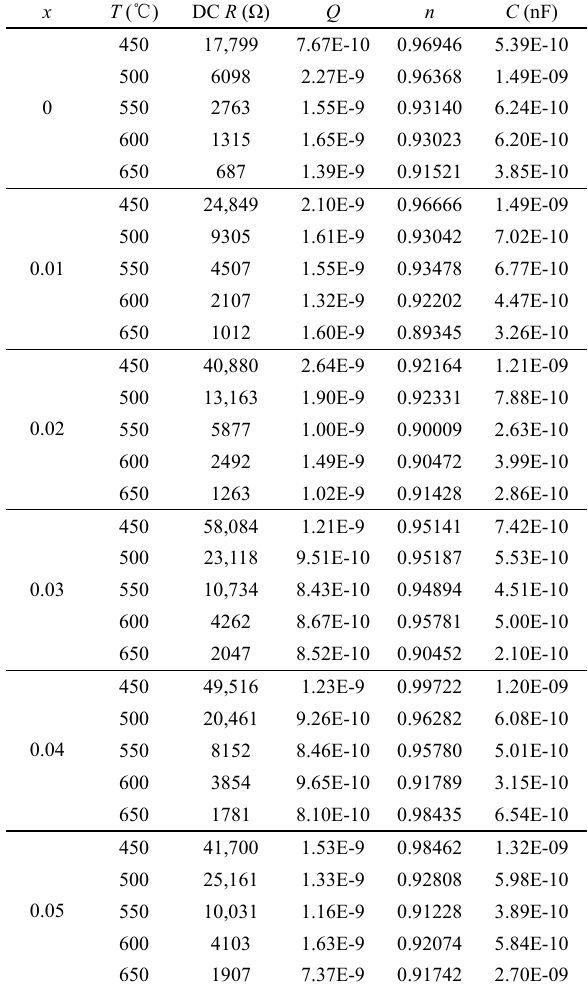
Table 3 Fitting parameters obtained from impedance